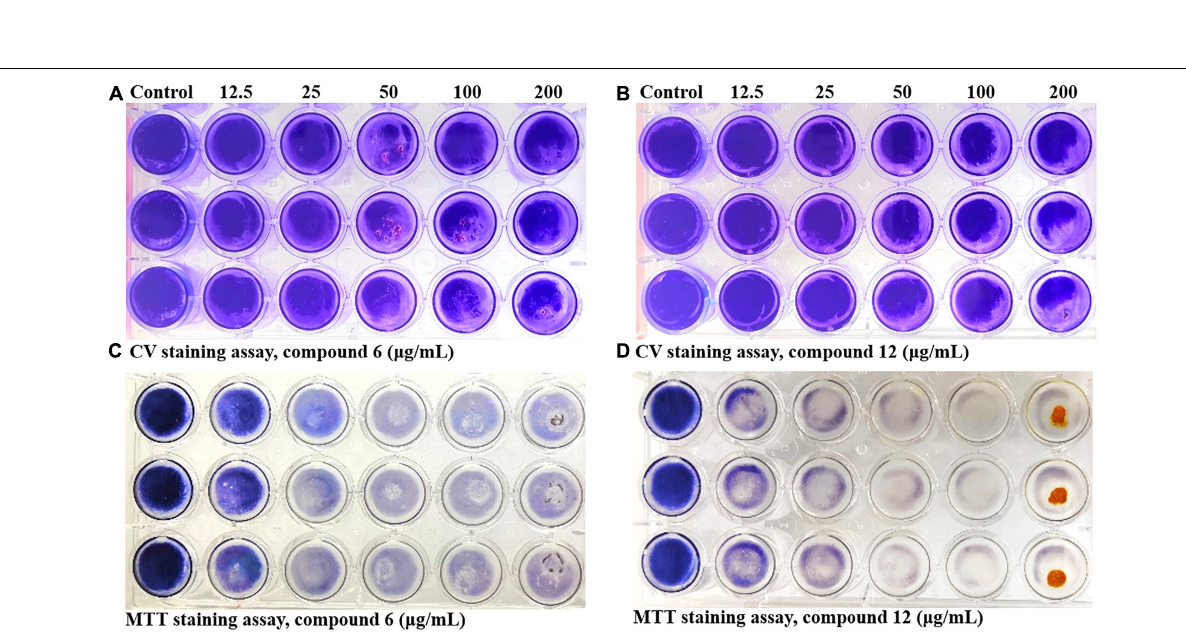
Frontiers in Microbiology |